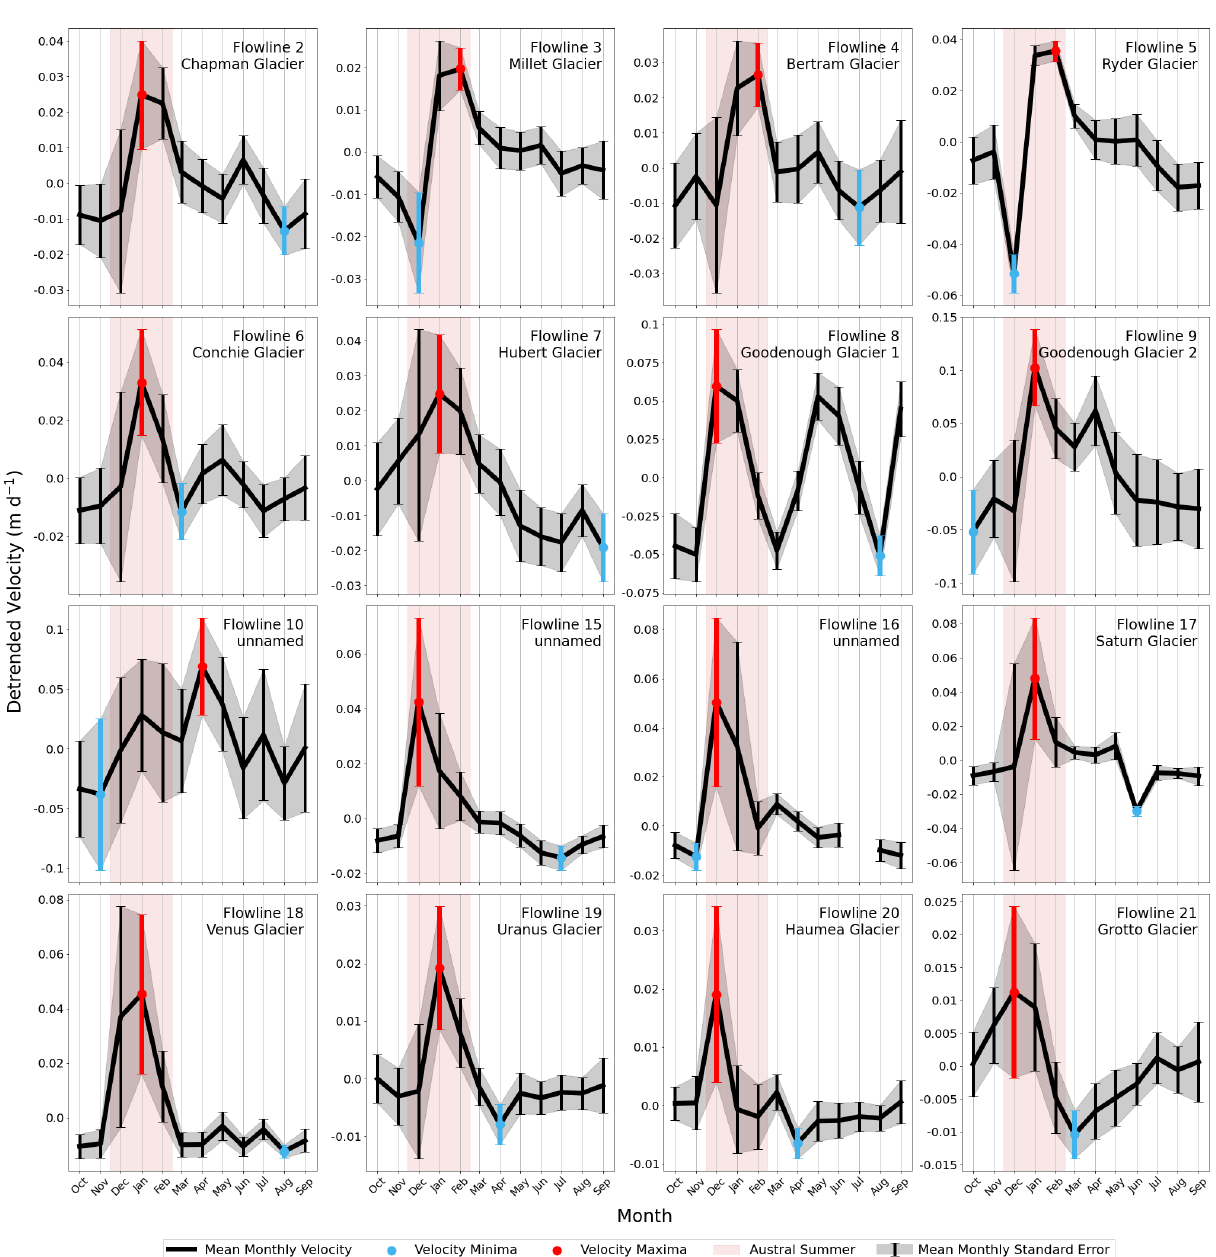
Figure 5. Detrended SAR-derived observations of mean monthly ice flow between 2014 and 2020 (black) and associated mean monthly standard error (grey shading). Observations are averaged across the 10km 2 dashed boxes shown in Fig. 1. Blue and red error bounds denote velocity minima and maxima, respectively. Translucent red shading denotes the timing of austral summertime (December–February, inclusive). Note that the y -axis limits vary between